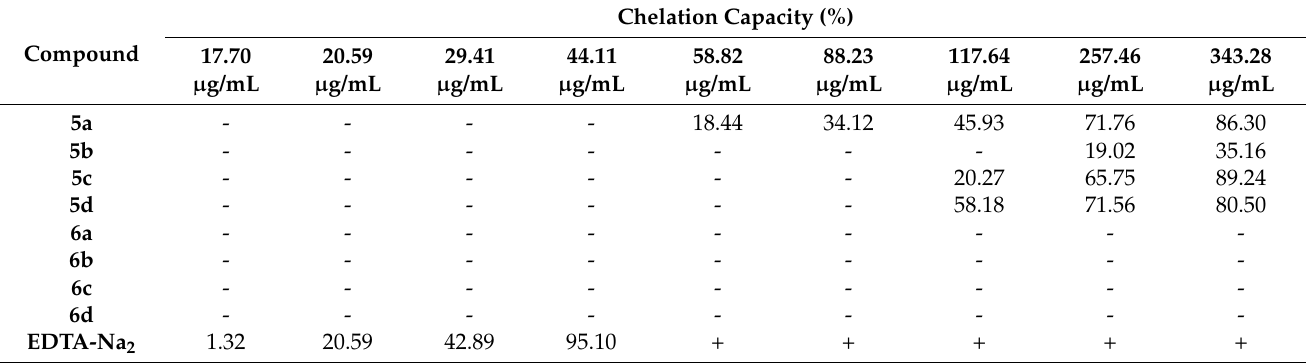
Table 5. Results of the ferrous ions chelation capacity